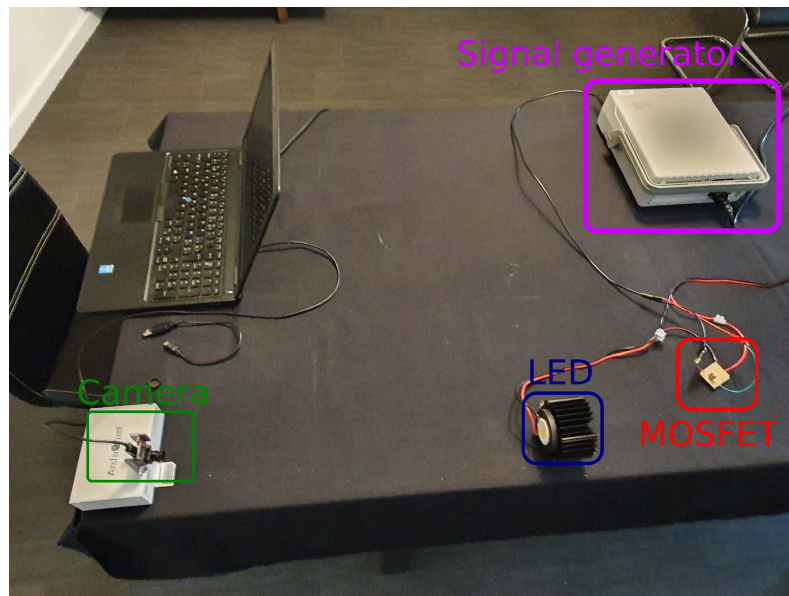
Figure 10. Experimental setup for transmitter–receiver distance experiments. Table 5. Frequency estimation accuracy as a function of the transmitter–receiver distance. Field Of View (FOV) is kept fixed at 60 degrees.